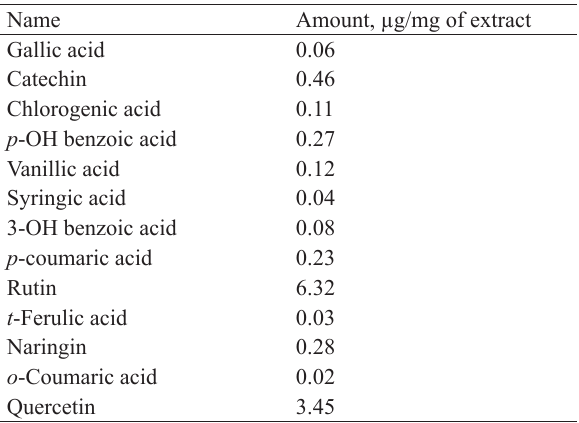
Table 4 Minimum inhibitory concentration (MIC) and minimum bactericidal concentration